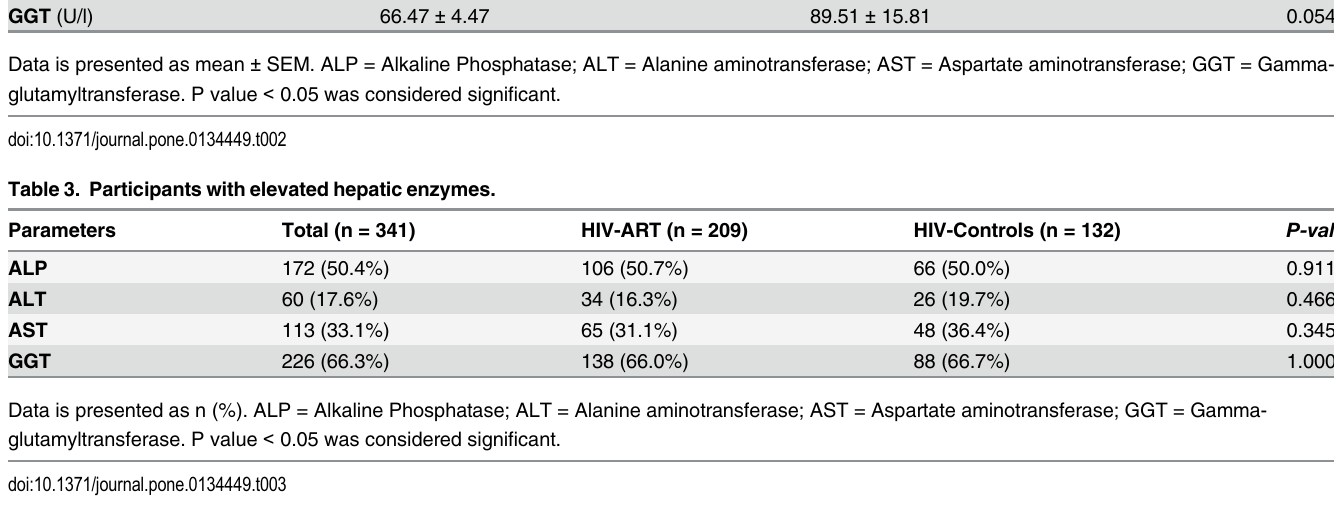
In Table 3, there was no significant difference between proportion of individuals with ele- vated hepatic enzymes, when compared between HIV-ART and HIV-Controls (P > 0.05). When this was compared within and across gender, all enzymes but the GGT, did not differ significantly between HIV-ART and HIV-Controls. Of both groups compared, there were sig- nificantly more males than females with elevated GGT ( P < 0.0001 each). [Table 4] Table 4. Comparison of hepatic enzyme levels between HIV-ART and HIV-Controls relative to gender. Parameters HIV-ART Male (n =